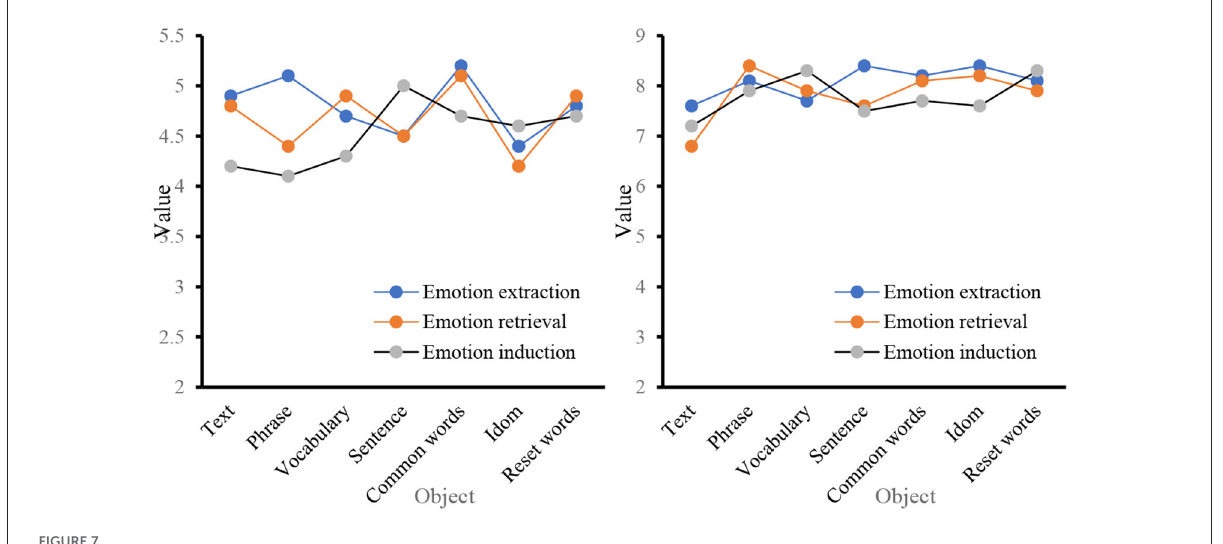
FIGURE7 Length of evaluation